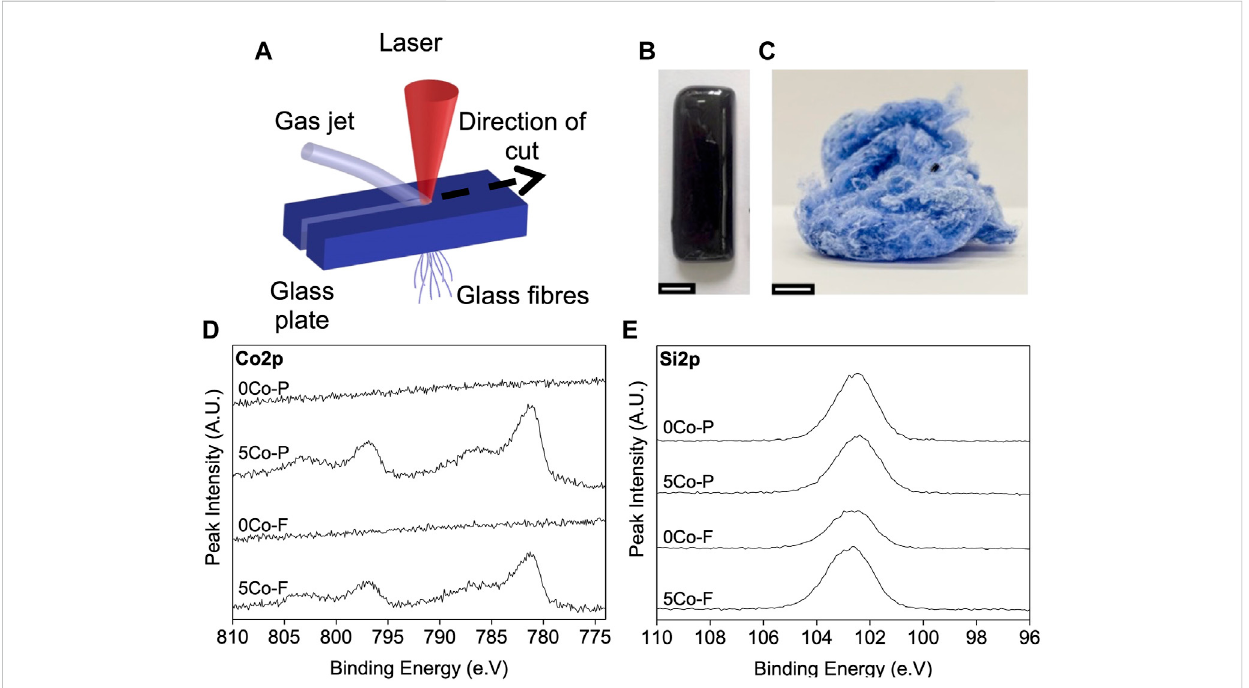
FIGURE 1 (A) Schematic of thelaser spinning processusing aglass precursor plate (B) photographof an example ofabioactiveglass precursorplate (scale bar is 1 cm) (C) mesh of fi bres produced (D) XPS core line spectra of cobalt (Co2p) showing no difference in oxidation state of Co between the cobalt glass fi bres and particles, and the core line spectra of silica (Si2p) (E) showing no difference in oxidation state of Si between the 5Co or 0Co glass fi bres (5Co-F and 0Co-F) or particles (5Co-P and